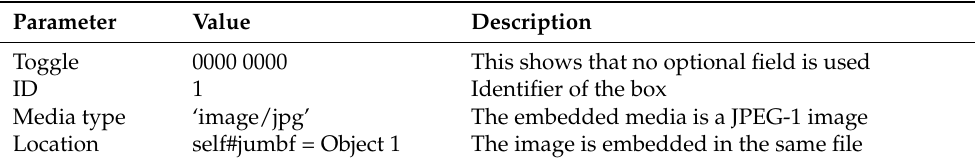
Table A3. Values of the first OBMB parameters for the first example.